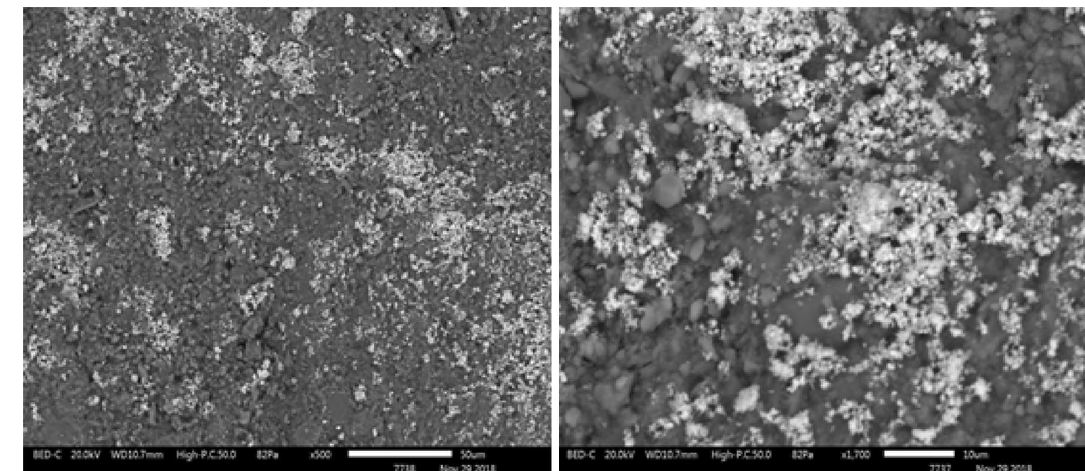
Fig. 8 SEM image of the shale sample after exposer to fluid